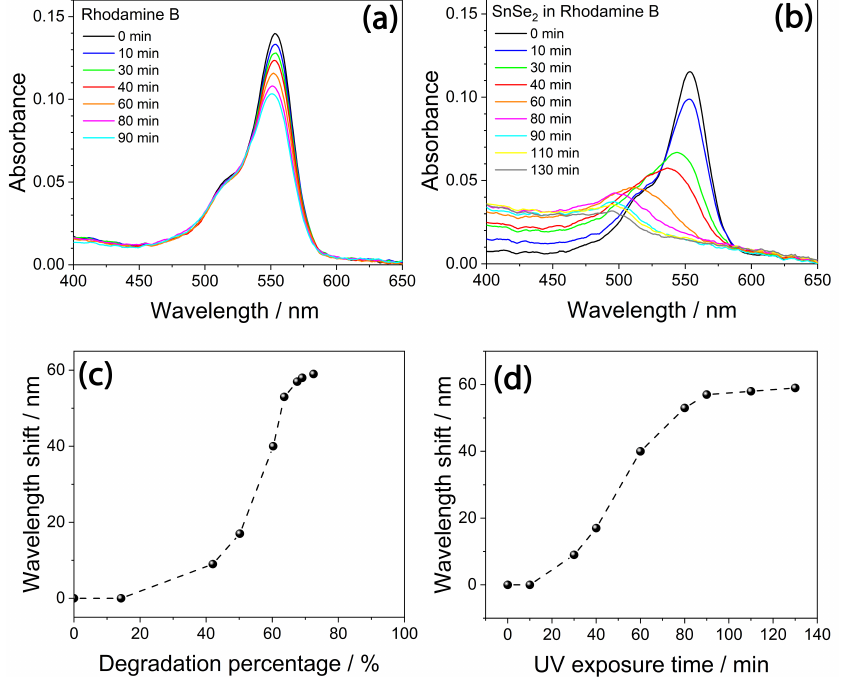
Figure 7. ( a ) UV–Vis absorption spectra of an aqueous solution of RhB (2.5 × 10 − 6 mol L − 1 ) as a function of UV (365 nm) exposure time. ( b ) UV-Vis absorption spectra of the aqueous RhB solution containing dispersed SnSe 2 flakes (0.07 g L − 1 ) as a function of UV exposure time. ( c , d ) Percentage absorbance decrease and wavelength shift as a function of the UV exposure time. The data were taken from ( b ), using the maxima at 560 nm as reference for the calculation of the percentage decrease and wavelength shift. The line is a guide for the